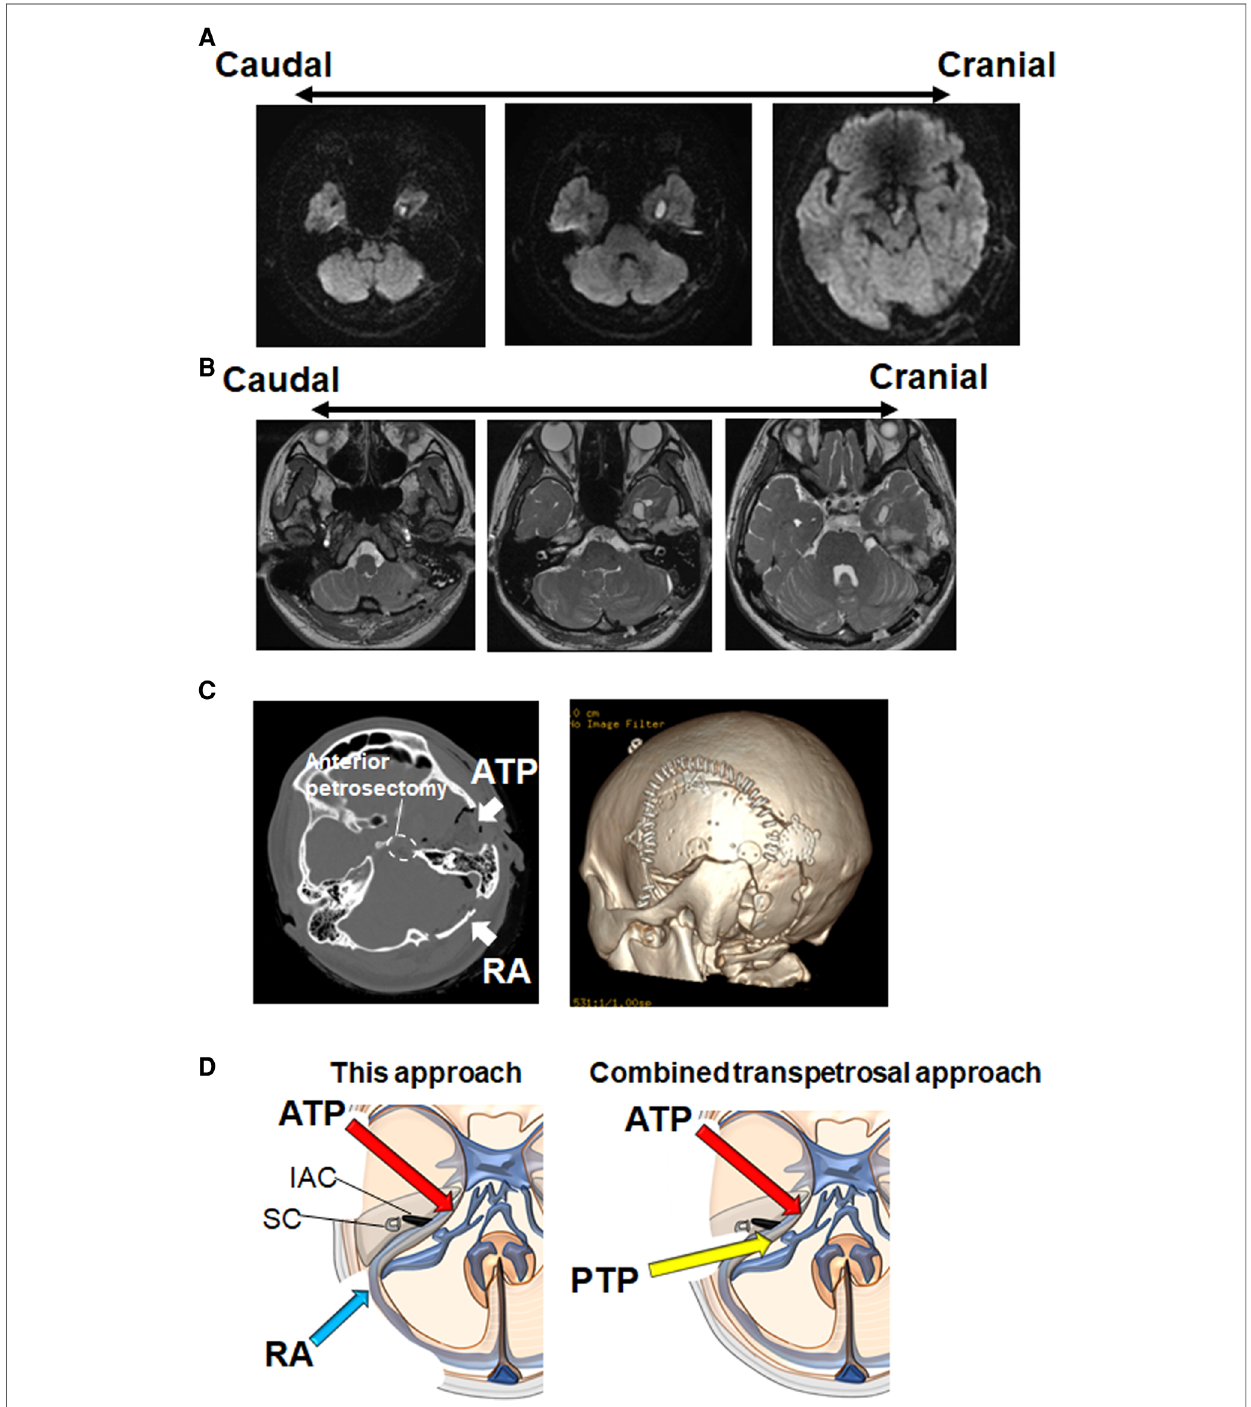
FIGURE 4 Postoperative radiographic fi ndings. ( A ) Postoperative DWI shows near-total removal of epidermoid cyst in the supra/infra tentorial regions. A small amount of tumor remains around the optic chiasm. ( B ) Postoperative FIESTA shows that the decompression of trochlear nerve, trigeminal nerve, facial/vestibulocochlear nerves, LCN, and hypoglossal nerve is achieved. ( C ) Head CT bone window images show the one-piece temporal- suboccipital craniotomy (left panel: axial view, right panel: three-dimensional reconstruction). ( D ) Schematic diagram illustrating the difference between this approach and CTP. FIESTA, fast imaging employing steady-state acquisition; LCN, lower cranial nerves; CTP, combined transpetrosal approach; ATP, anterior transpetrosal approach; IAC, internal auditory canal; PTP, posterior transpetrosal approach; RA, retrosigmoid approach; SC, semicircular